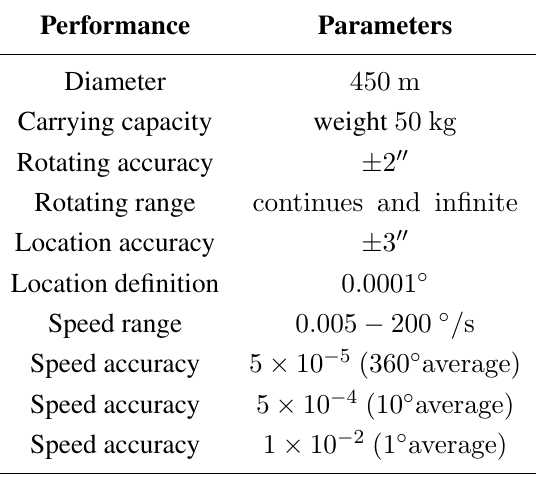
Table 10. Performances of the 920E single axis velocity and position